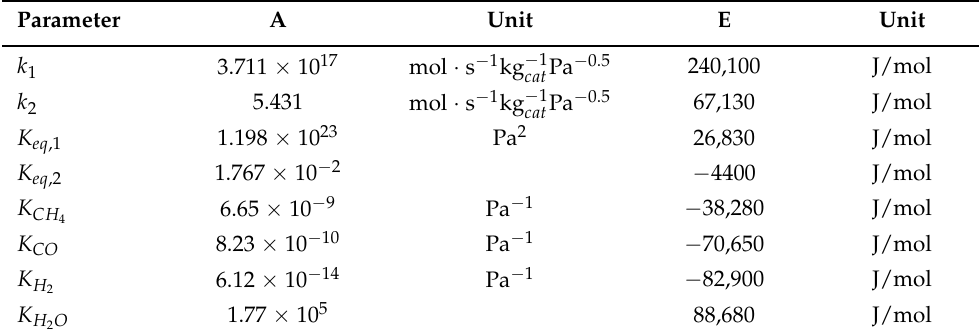
Table 2. Kinetic parameter for the calculation of reaction rate